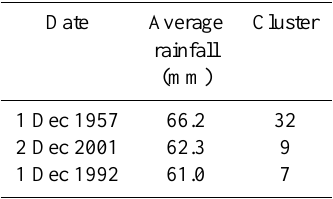
Fig. 11. Geopotential height pattern on 1 December 1992 (Clus- Fig. 9. Geopotential height pattern on 1 December 1957 (Clus- ter 7) with an average rainfall of 61.0mm (unit: gpm). ter 32) with an average rainfall of 66.2mm (unit: gpm). Fig. 9. Geopotential height pattern on 1 December 1957 (Cluster 32) with an average Fig. 11 . Geopotential height pattern on 1 December 1992 (Cluster 7) with an average Table 1. Events with the most extreme values of rainfall (exceeding 60mm); the corresponding Cluster numbers refer to the 36-cluster rainfall of 61.0 mm (unit: gpm). rainfall of 66.2mm (unit: gpm).